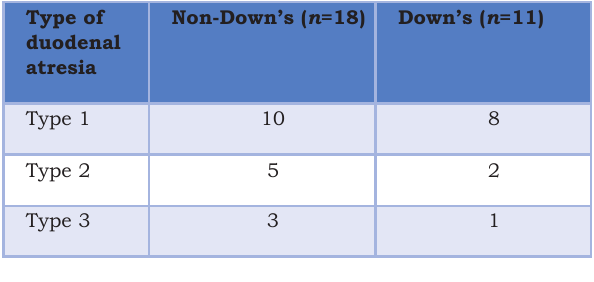
Table 3: Post‑operative management Variable